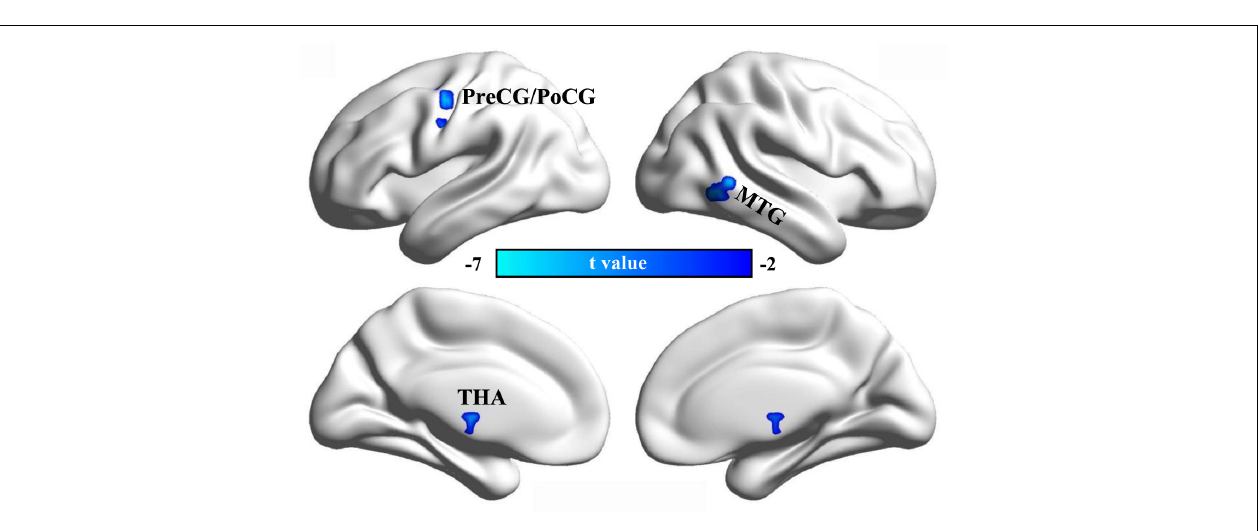
FIGURE 2 | Changed dynamic ALFF in CDP patients. A two-sample t -test was used to compare the dynamic ALFF maps between CDP patients and healthy controls. Significantly decreased dynamic ALFF in left precentral/postcentral gyrus, right posterior middle temporal gyrus, and bilateral thalamus were found in CDP